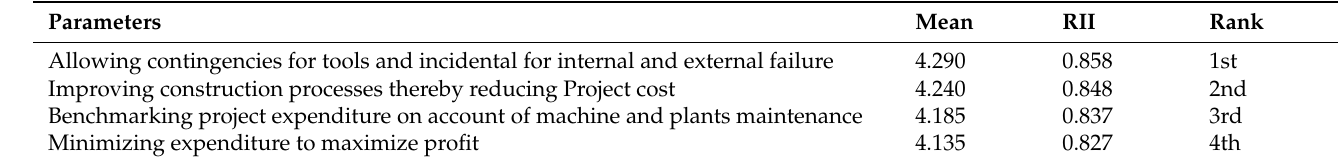
Table 8. Parameters on quality cost objectives.